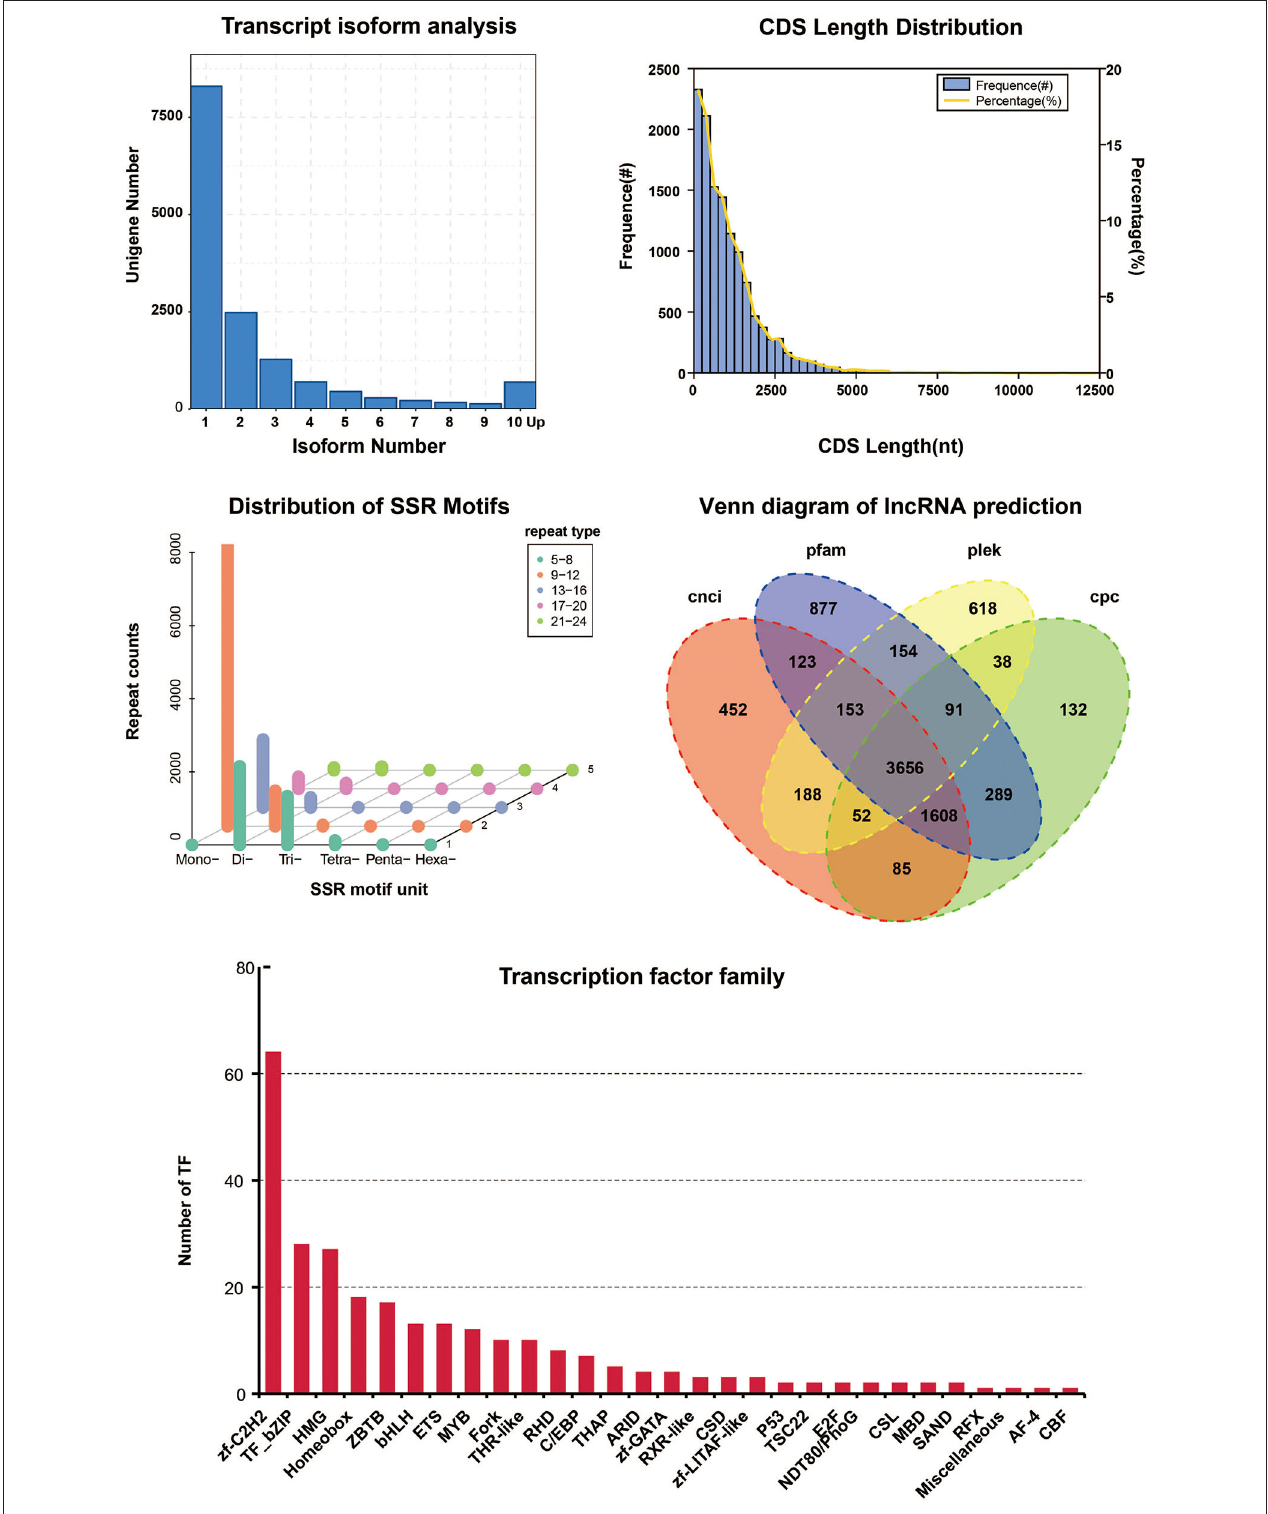
FIGURE 2 | Utilization of A. japonicus full-length transcriptome. (1) Isoform number per gene in A. japonicus full-length transcriptome. (2) Coding region length distribution of A. japonicus full-length transcriptome. (3) Distribution of SSR motifs. (4) Venn diagram of lncRNA prediction; (5) Transcriptional factor prediction of A. japonicus full-length